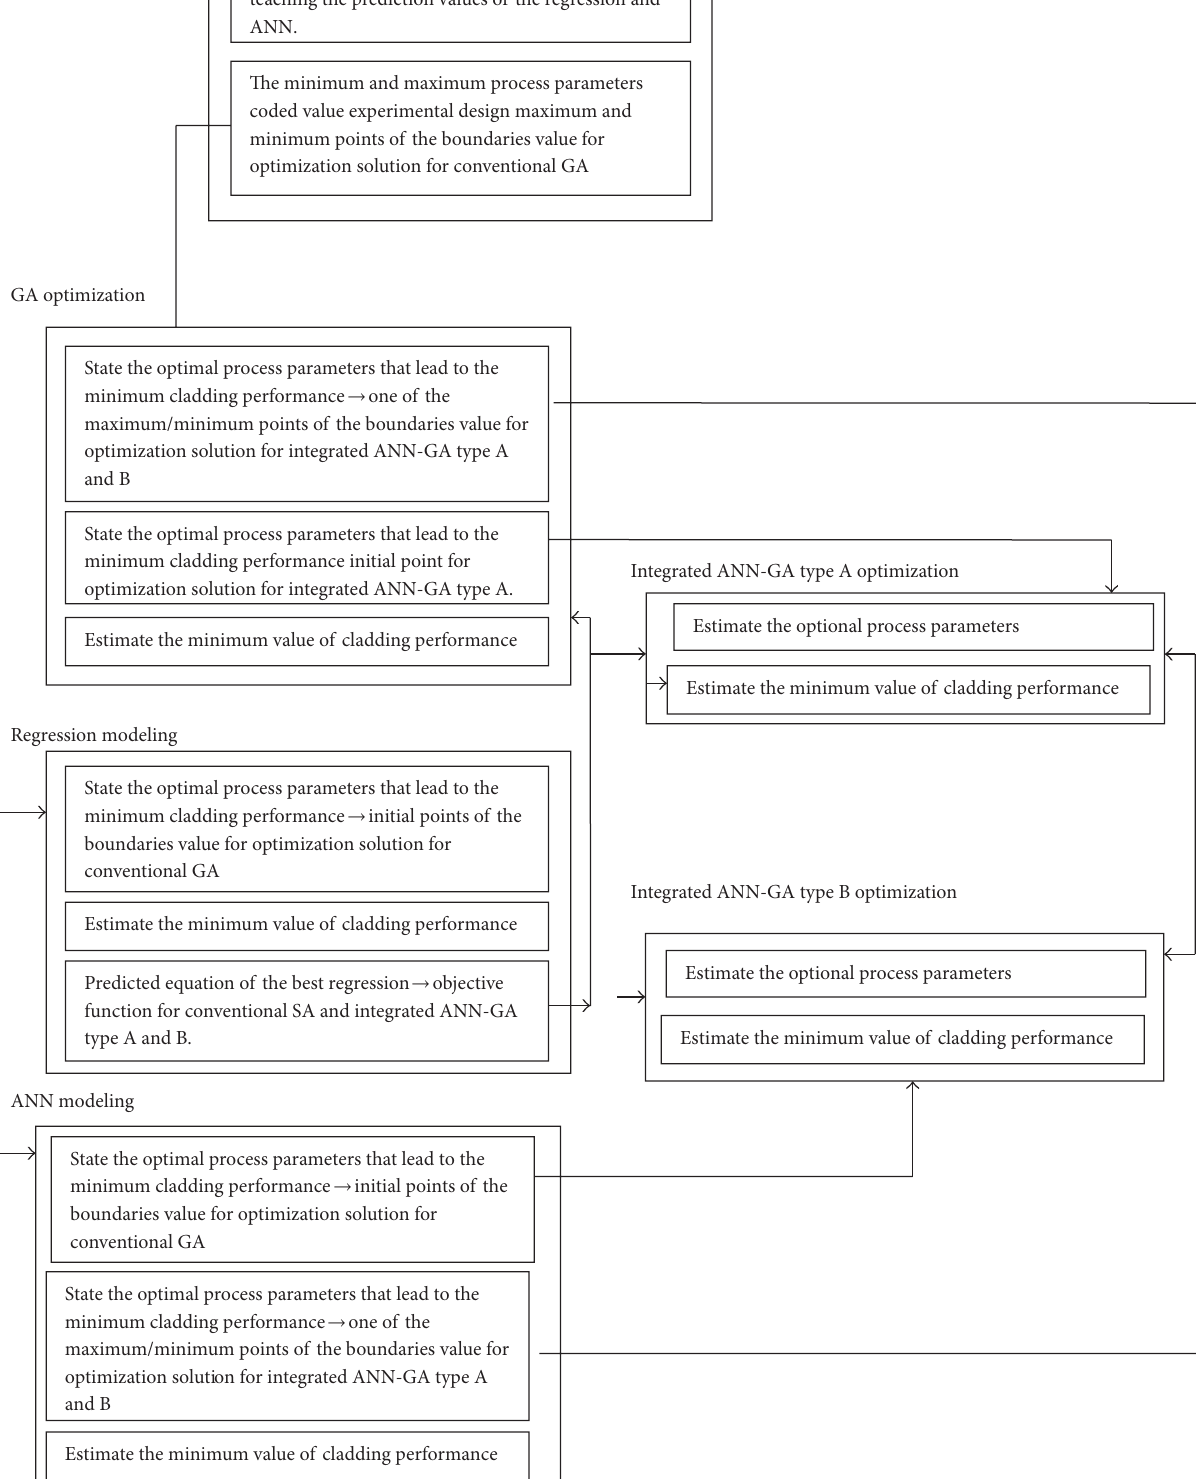
Figure 10: Integrated ANN-GA optimization